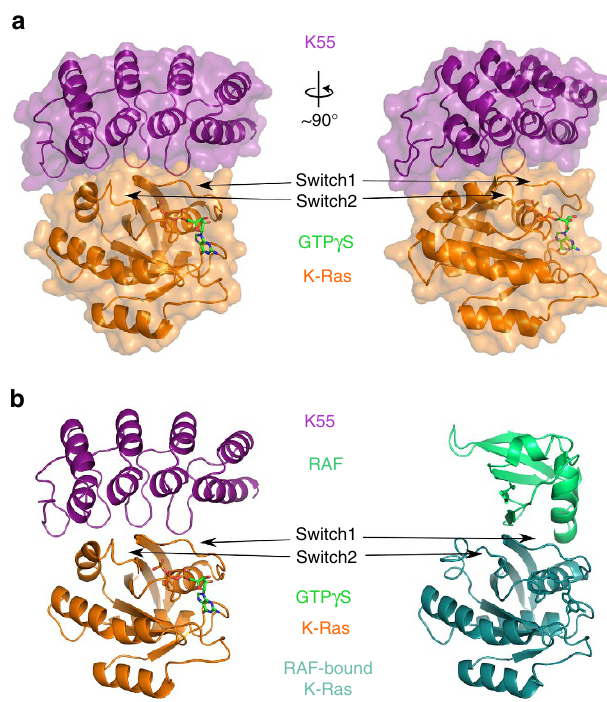
Figure 3 | Crystal structure of the Ras/Raf inhibitor DARPin K55 binding to K-Ras G12V at 2.3Å resolution. DARPin K55 is shown binding to the active form of K-Ras G12V, crystallized in the presence of an uncleavable GTP analogue to ensure an active conformation. Two views of the complex are shown, rotated at 90 (cid:2) about a vertical axis, with switch 1 and 2 regions annotated ( a ). A comparison of the K-Ras/K55 complex with the KRas/RAF complex (PDB code: 3KUD) in b shows that the RAF and K55 binding sites overlap significantly and the switch1 loops of K-Ras in each complex are in essentially identical